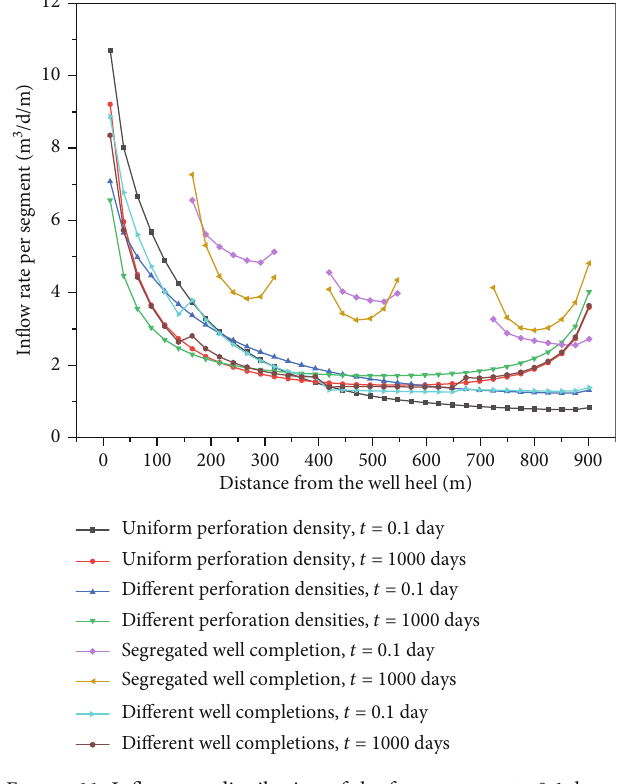
Figure 11: In fl ow rate distribution of the four cases at t = 0 : 1days and t = 1000 days .